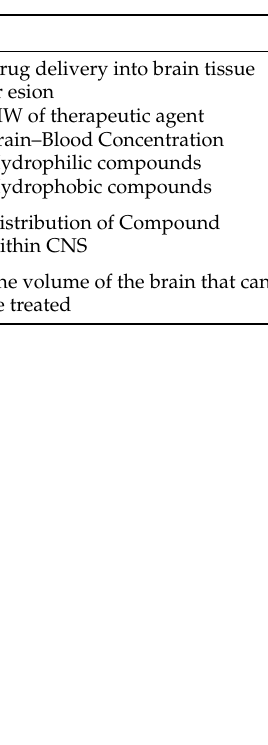
Table 3. Comparison of intracerebral drug delivery